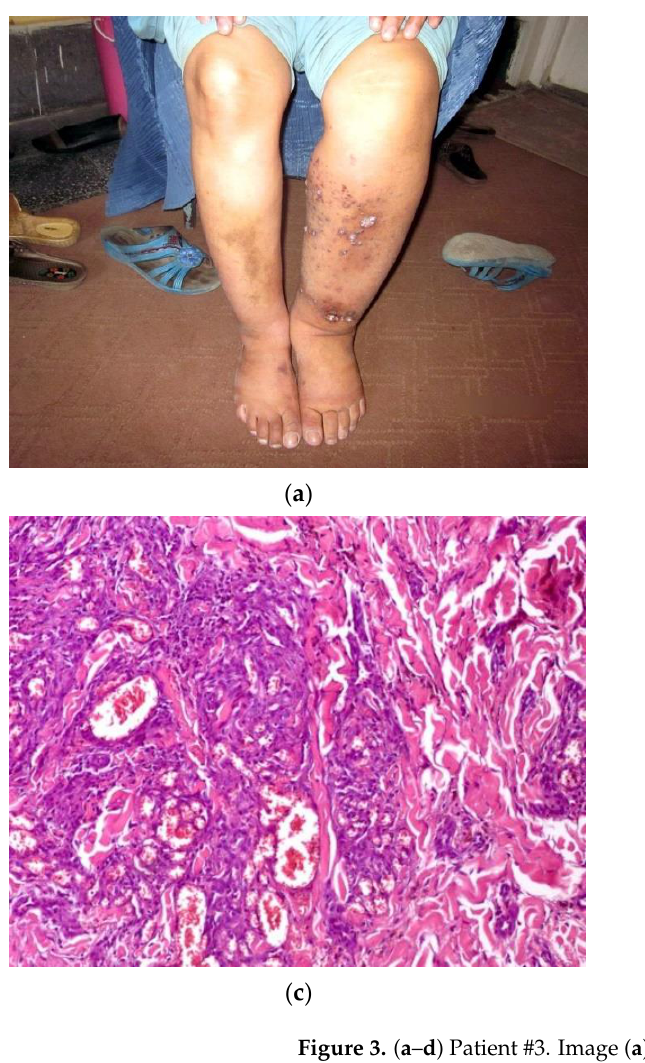
6 Figure 2. ( a – d ) Patient #2. Image ( a ) Multiple, violaceous patches, nodules, and papules of bilateral lower extremities (left > right) with mild lymphedema of left leg. Image ( b ) H&E 40×. Multiple nod- ules within the deep dermis. Image ( c ) H&E 200×. Spindled cell proliferation forming slit-like spaces. No significant RBC extravasation is identified. Image ( d ) IHC HHV-8 200×. Strong and diffuse nu- clear staining of spindled cells within the dermis. 2.3. Case 3 The patient (#3) (Figure 3) is a 45-year-old female from a remote province with a four- year history of unilateral left lower extremity edema, followed by a seven-month history of increasing violaceous papules and nodules of the same extremity (Figure 3a). These